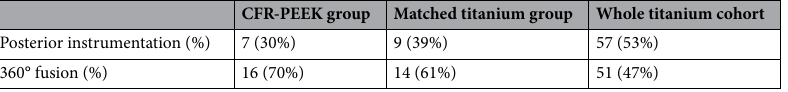
Table 2. Number of posterior fusion and 360° instrumentation of CFR-PEEK group, matched titanium group and whole titanium cohort. Operative strategy used. To compare the number of posterior fusion versus 360° fusion between the CFR-PEEK group and the matched titanium group and between the CFR-PEEK group and the whole titanium group Fisher’s exact test was used. There was no significant difference. CFR-PEEK group versus matched titanium group: p = 0.758. CFR-PEEK group versus whole titanium group: p = 0.067.